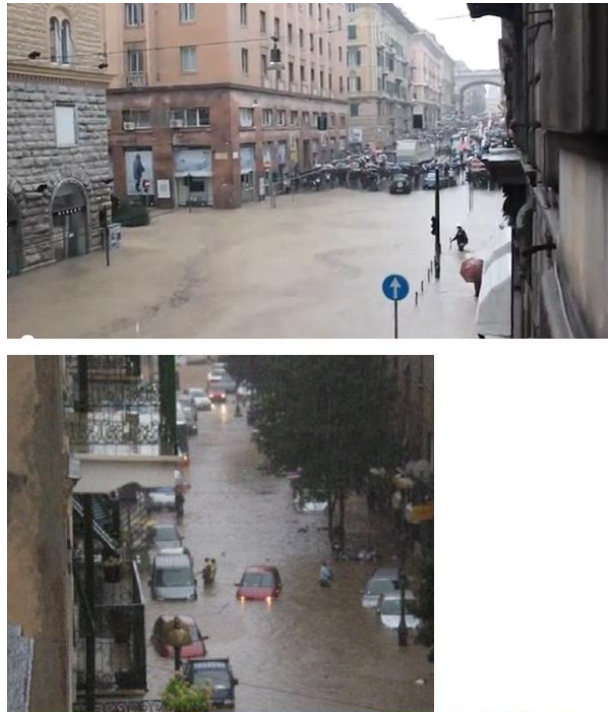
Fig. 3. Flash flood in Genoa on the 4 November 2011 (from the